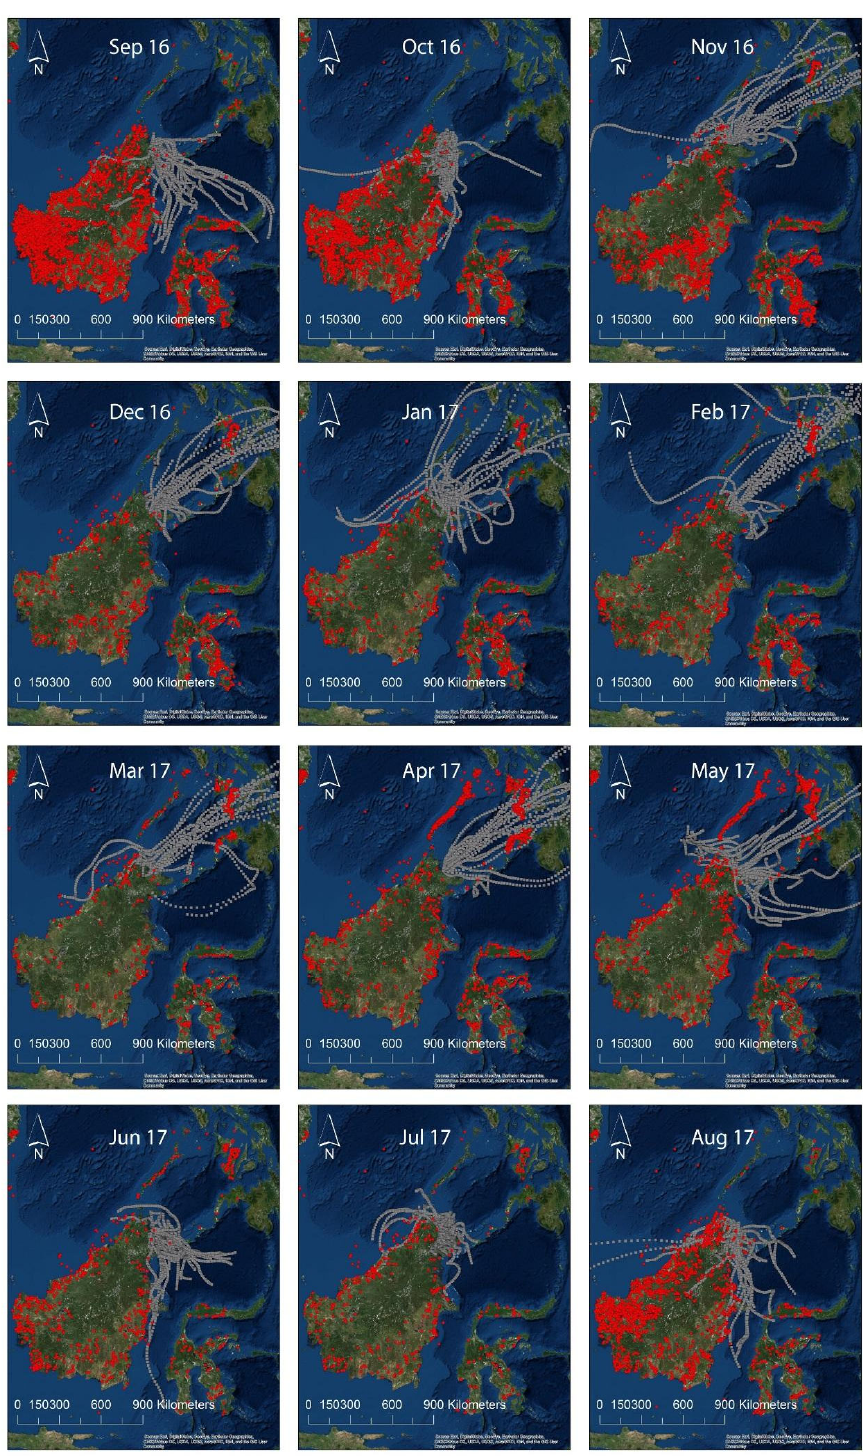
Figure 3. Intersection of the fire map (where the fires are represented by the red dots) obtained for Borneo and surrounding regions (MODIS C6 satellites https://earthdata.nasa.gov/earth-observation-data/near-real-time/firms accessed on 3 December 2018) with the backward wind trajectories (grey dotted lines) generated with the HYSPLIT model provided by NOAA. Backward wind trajectories were generated every two weeks at three different altitudes (50 m, 500 m and 1000 m) each running for 315 h. The backward wind trajectories end at our sample collection site in Sepilok, Sabah,